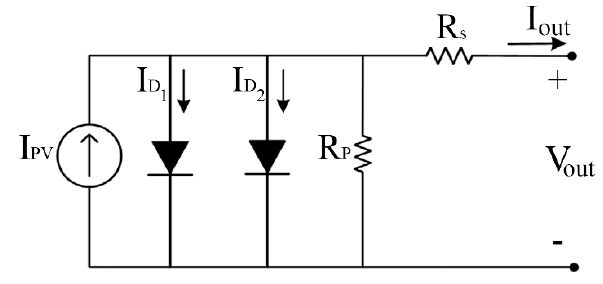
Figure 2. Two-diode model of a PV array .